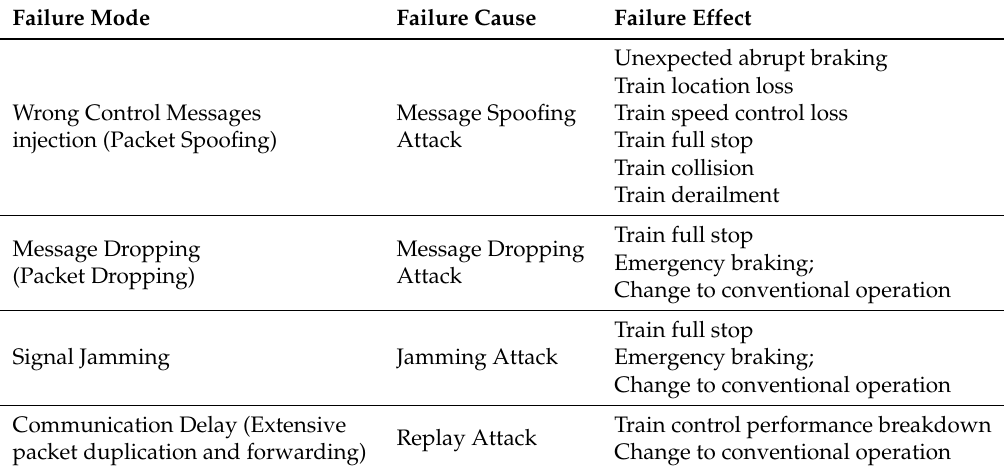
Table 11. Failure Modes, Causes and Effects.